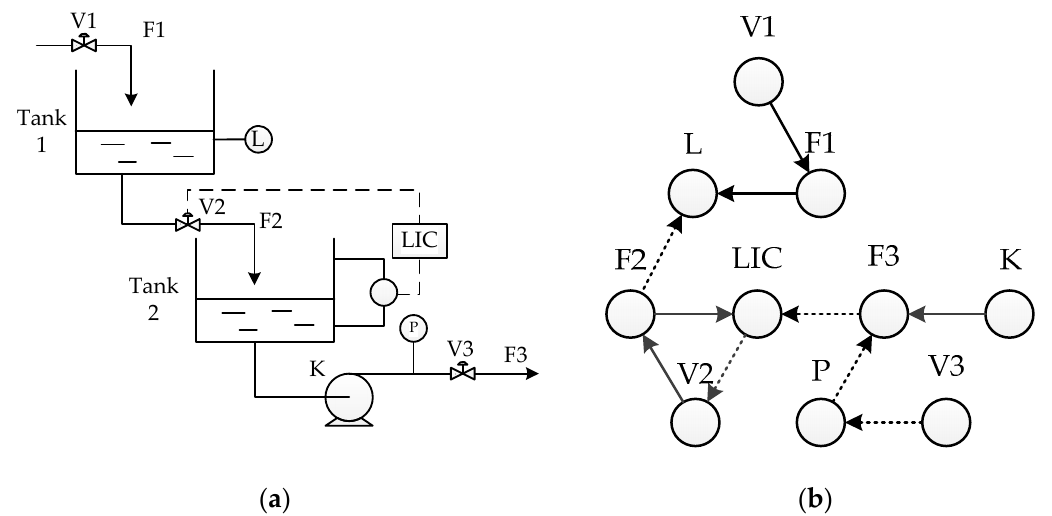
Figure 5. Schematic diagram of the liquid level control system and its SDG model: ( a ) liquid level control system; ( b ) SDG model of liquid level control system.